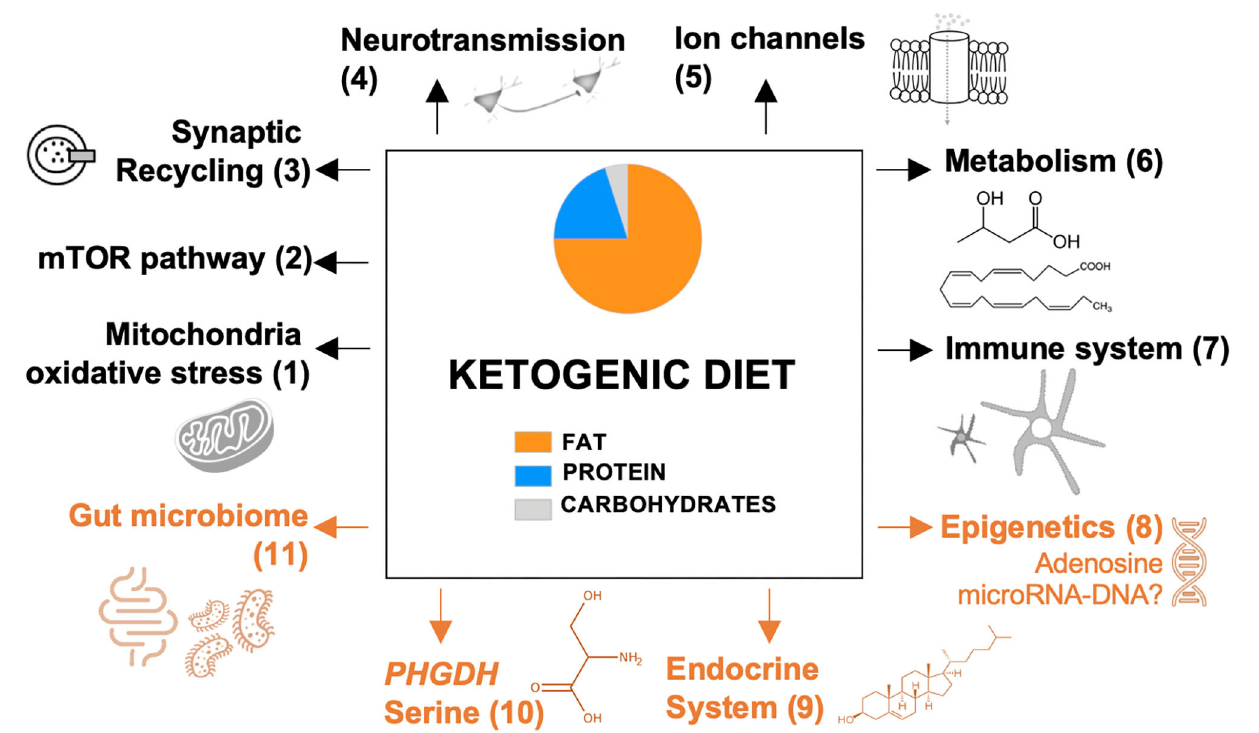
FIGURE 1 | Proposed mechanisms of the ketogenic diet. Previously reported pathways are presented in black; recently discovered and novel pathways are presented in orange. Each pathway is numbered, which refers to the reviewing literature focusing on this specific pathway: (1) Gavrilovici and Rho (23); (2) Danial et al. (26); (3) D’Andrea Meira et al. ( 24); (4) Gavrilovici and Rho (23); (5) Rho (25); (6) Boison (17) and Gavrilovici and Rho (23); (7) Koh et al. (15); (8-11) this review. mTOR, mammalian target of rapamycin; PHGDH , phosphoglycerate